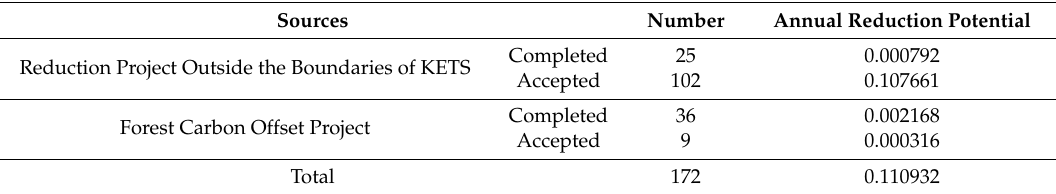
Table 7. The status of the reduction projects in 2016: a total of 12.31, in millions of tons. Sources